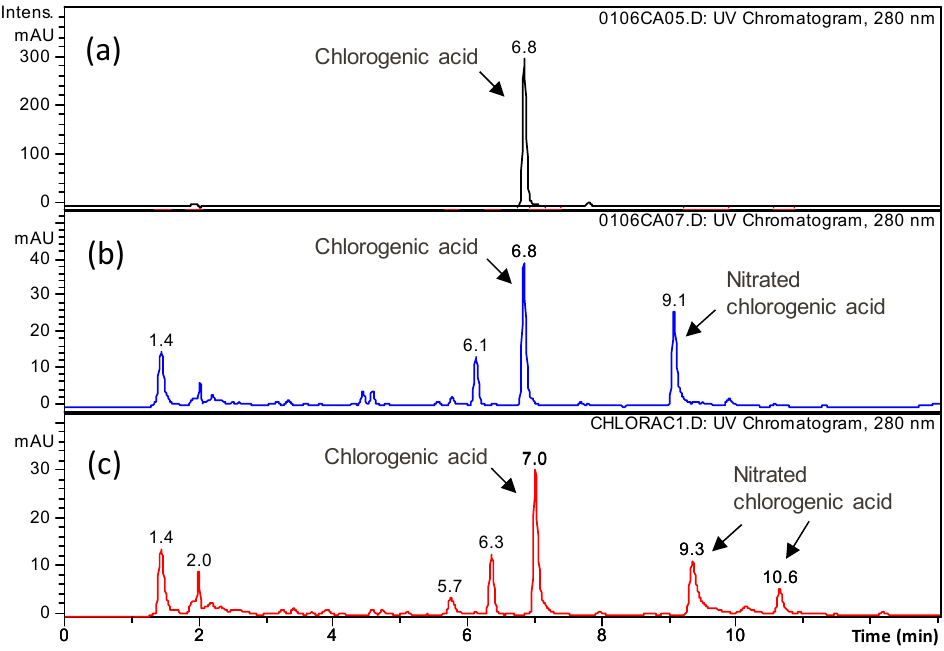
Figure 6. UV chromatograms (280 nm) of ( a ) untreated, ( b ) electrospray system (ES)-treated and ( c ) batch system (BS)-treated chlorogenic acid solution (5 × 10 − 5 M) in the phosphate buffer (21.6 mM, pH 3.2).